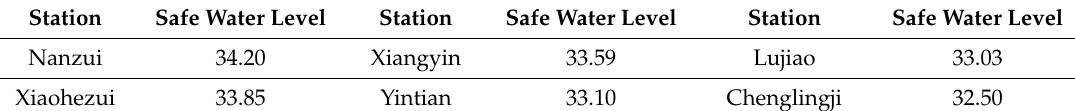
Table 2. The safe water level at each hydrological station (unit: m).